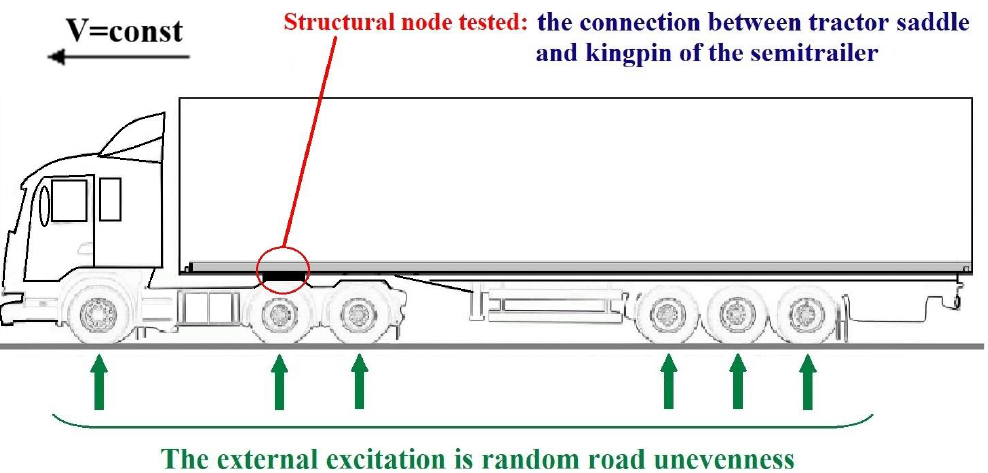
Figure 4. Tractor-semitrailer combination in a straight-line motion with a constant speed V. The structural node tested is the connection between tractor’s fifth wheel and the kingpin of the semitrailer.